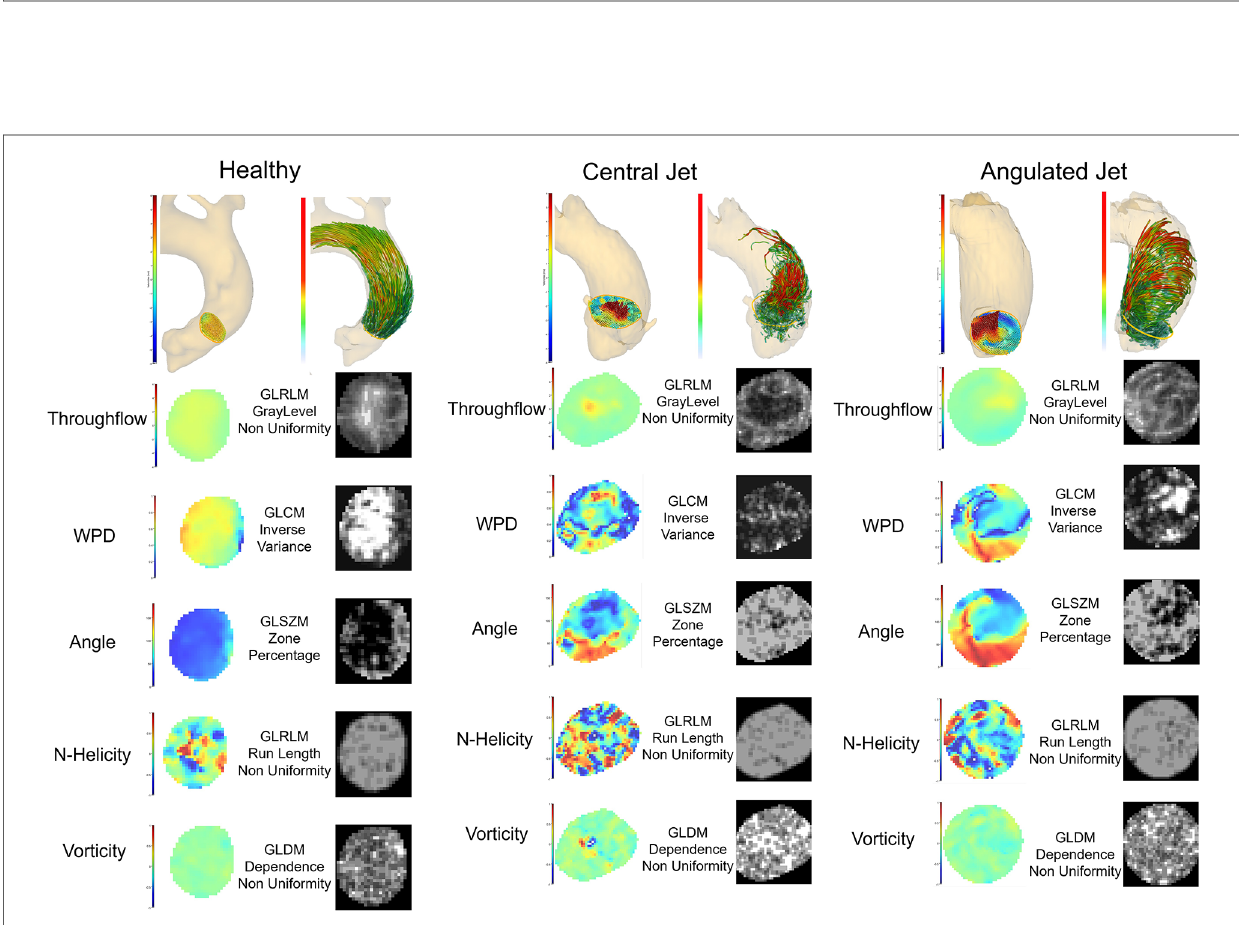
FIGURE 6 Radiomics feature analysis of the systolic cross-sectional fl ow pro fi le in a healthy subject and two patients with different fl ow patterns caused by aortic valve stenosis. 3D renderings show the fl ow pro fi le of the analysis plane A1.1 and the corresponding pathline visualization of the fl ow through this plane. The through fl ow, WPD, angle, normalized helicity and vorticity feature maps represent a systolic timepoint. The corresponding radiomics maps were extracted by the pyradiomics library and display the feature, which was most reproducible in the inter-scanner